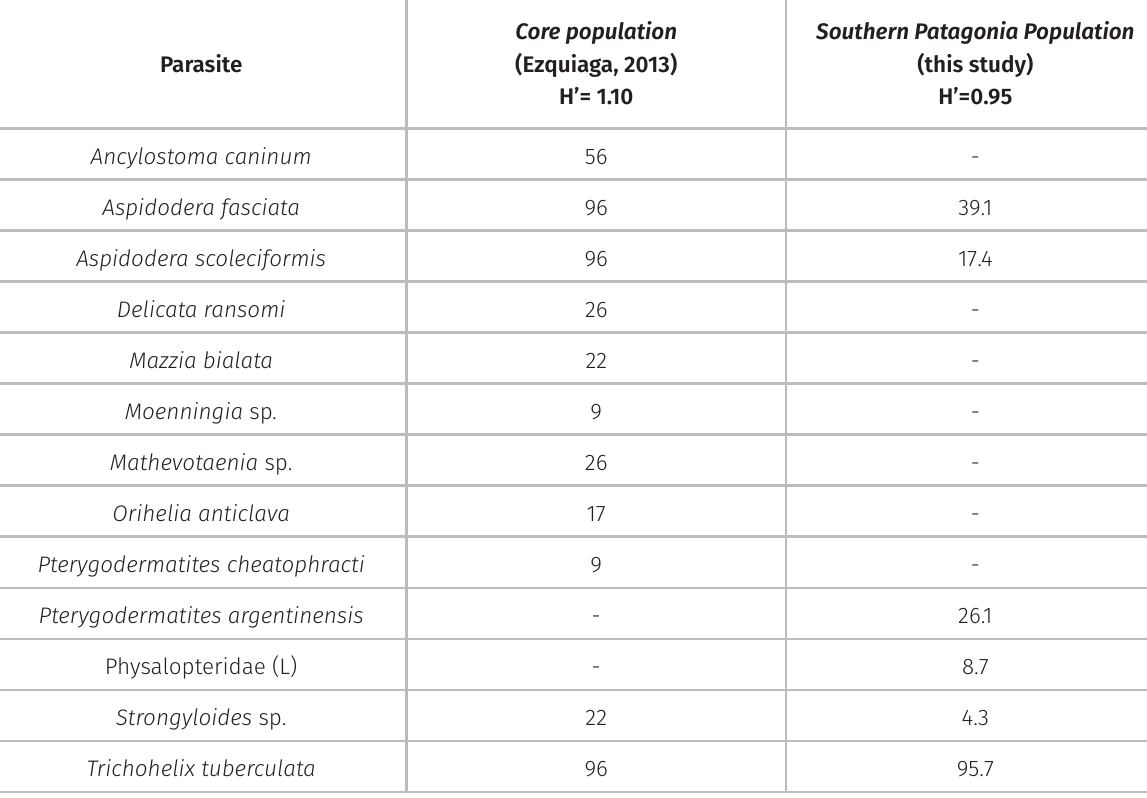
Table III. Helminthes prevalence (%) in Chaetophractus villosus core population and southern Patagonia population. H’= Shannon’s Diversity